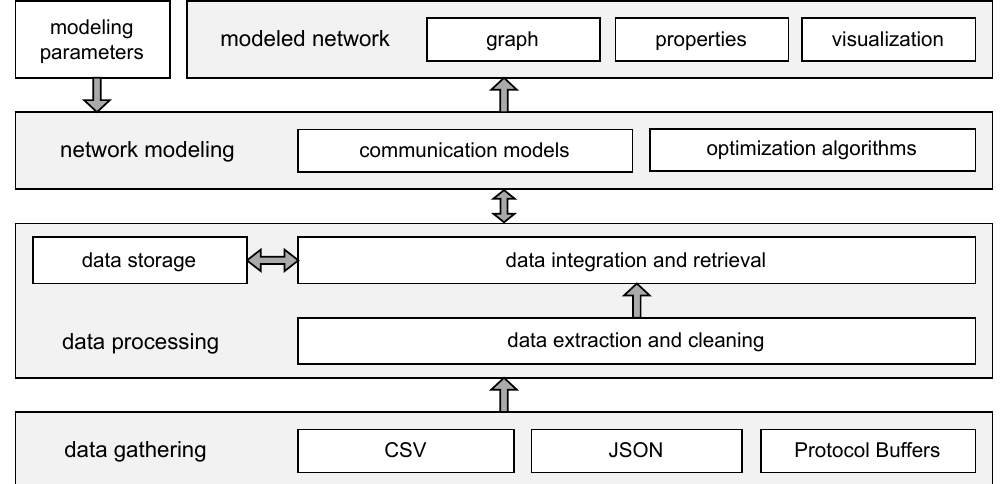
Figure 6. Open-data-based architecture for urban network